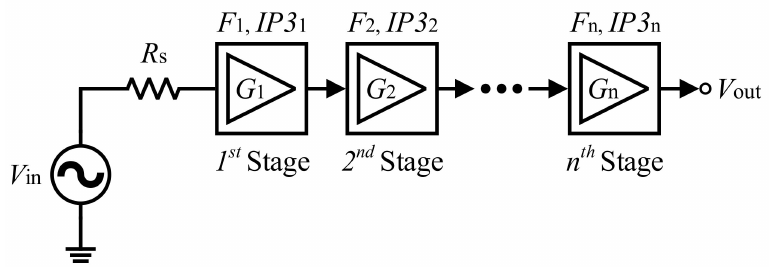
Figure 3. Block diagram of an n-stage cascaded